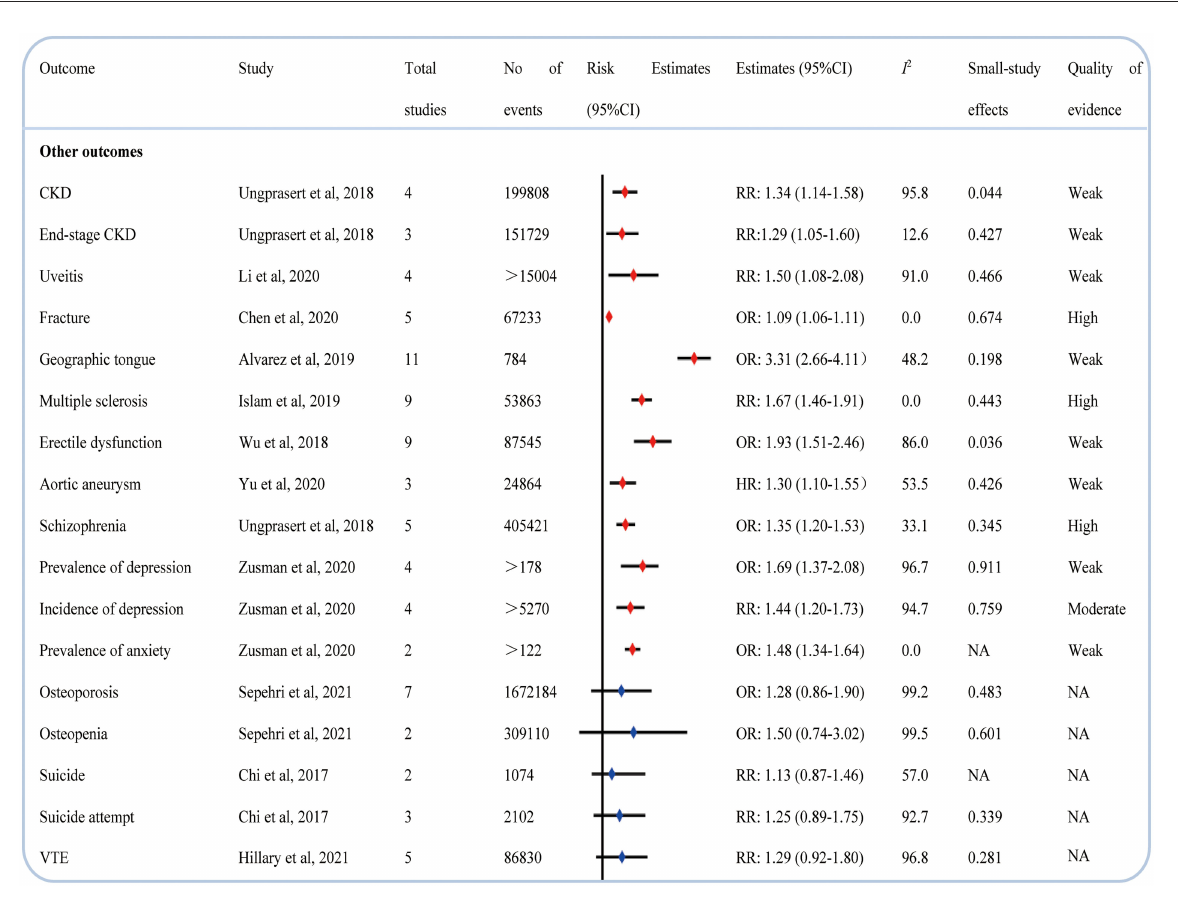
FIGURE8 Associations between psoriasis and other